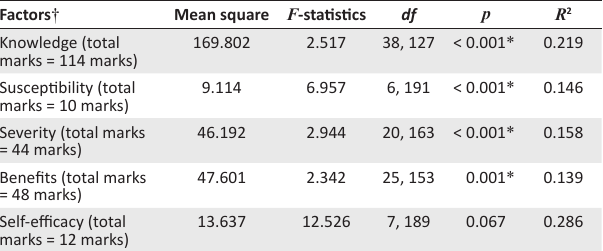
TABLE 4: The effectiveness of the knowledge transfer intervention with flood experience as covariate. Factors † Mean square F